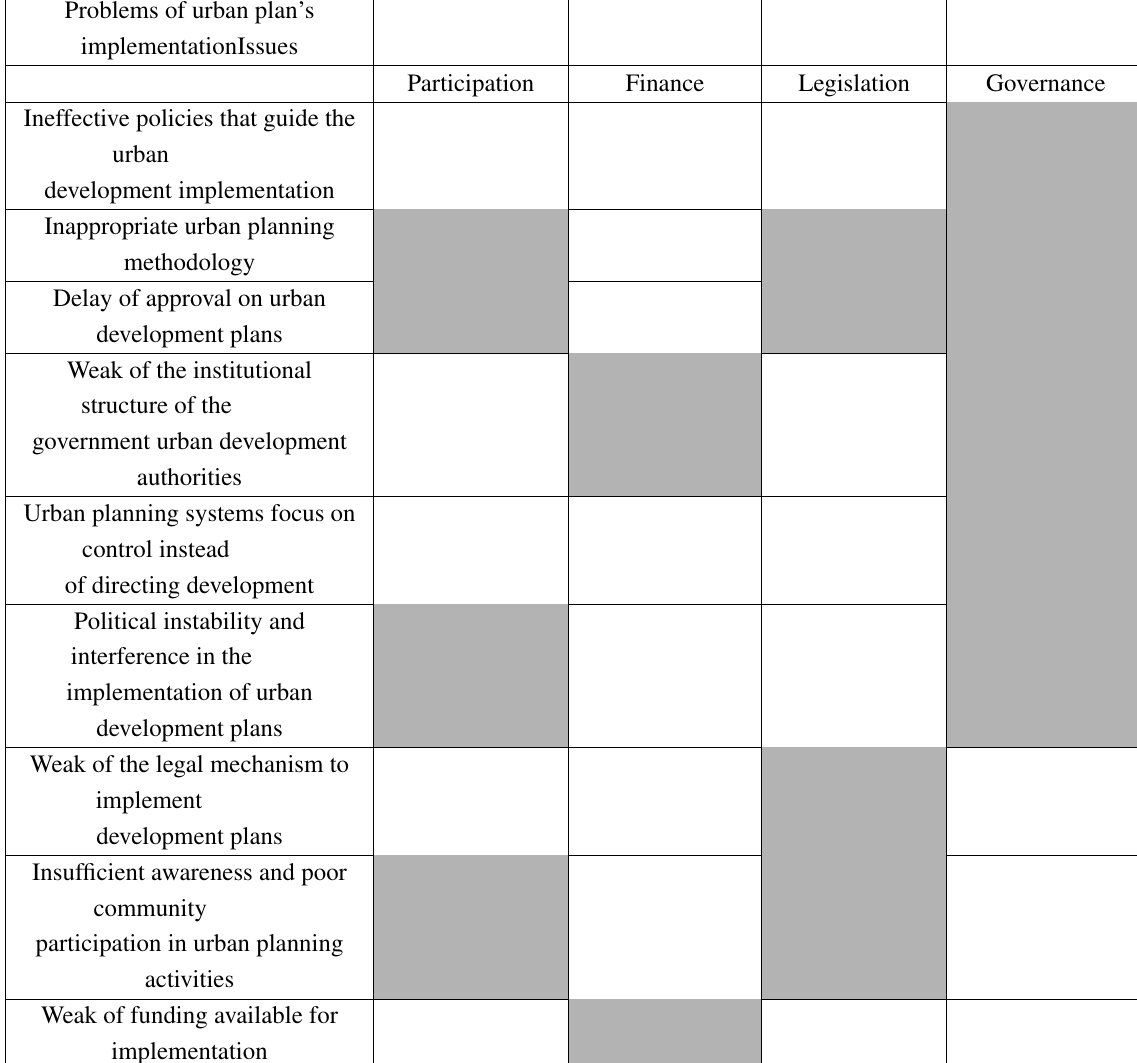
Table 1. Matrix of problems& issues of